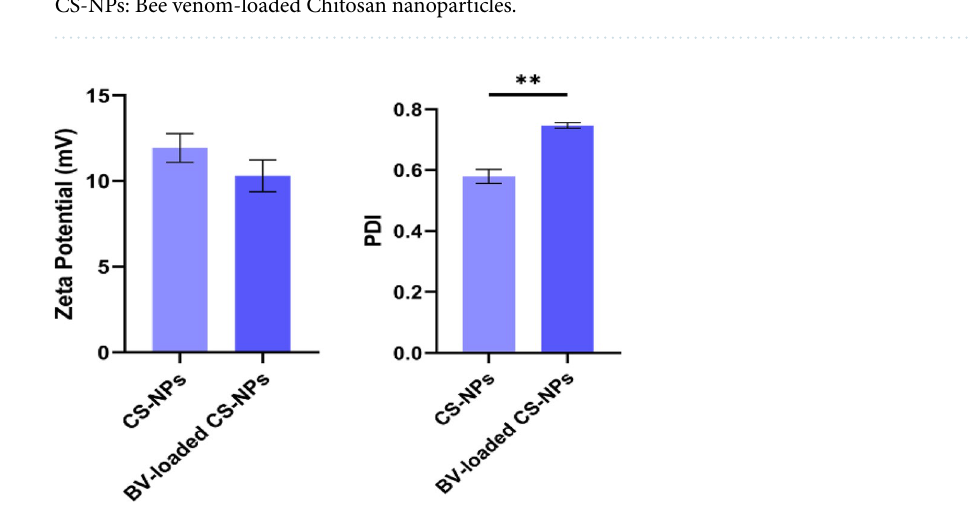
Figure 3. Surface net charge and NPs’ uniformity in the solution of CS-NPs and BV-loaded CS-NPs were measured using zeta potential and PDI. Data were analyzed using a one-sample T-test and represented as Mean ± Standard Error of mean (SEM). (**) is considered significant P < 0.01. -CSNPs: Chitosan nanoparticles, BV-loaded CS-NPs: Bee venom-loaded Chitosan